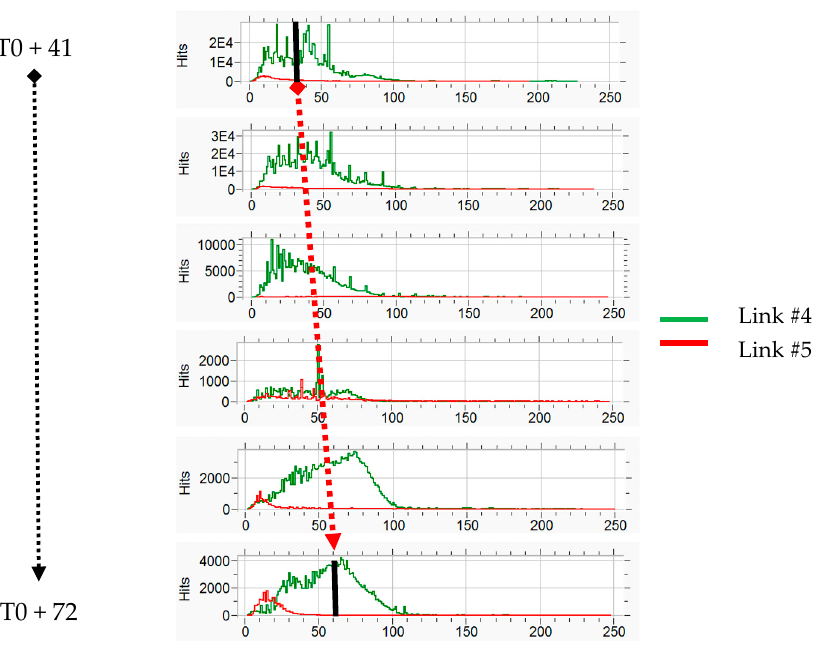
Figure 9. Hits vs. average frequency (kHz). Shift of the average frequency.